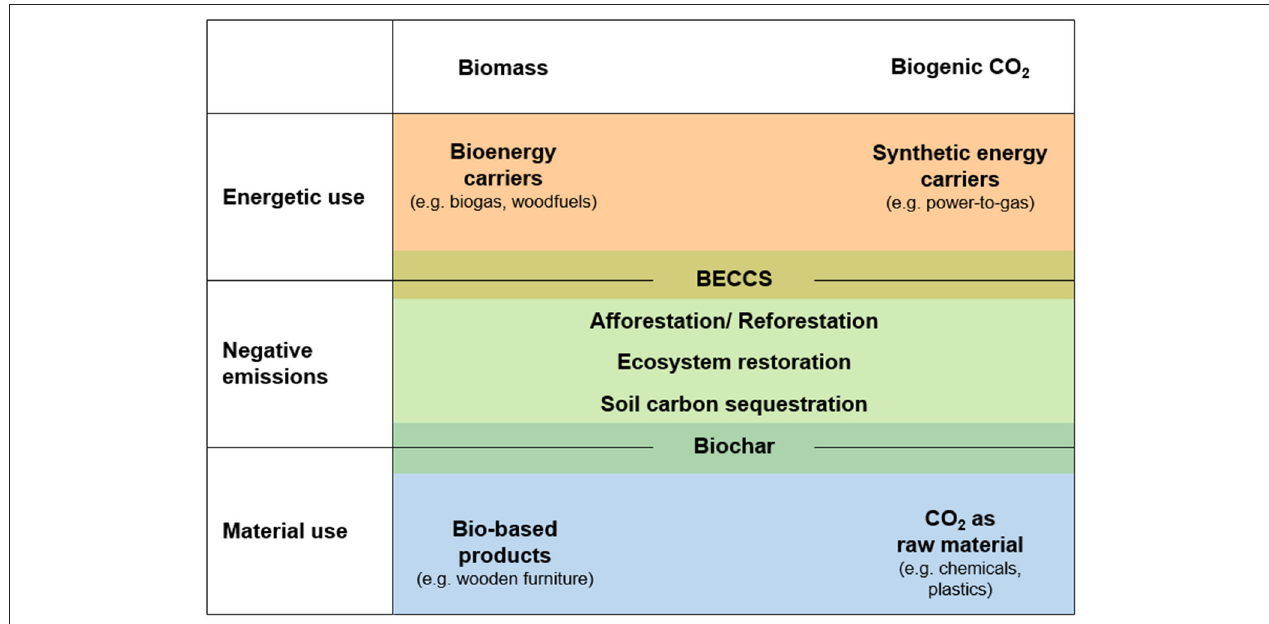
FIGURE 1 | Classification of biomass-based carbon removal options (BCO 2